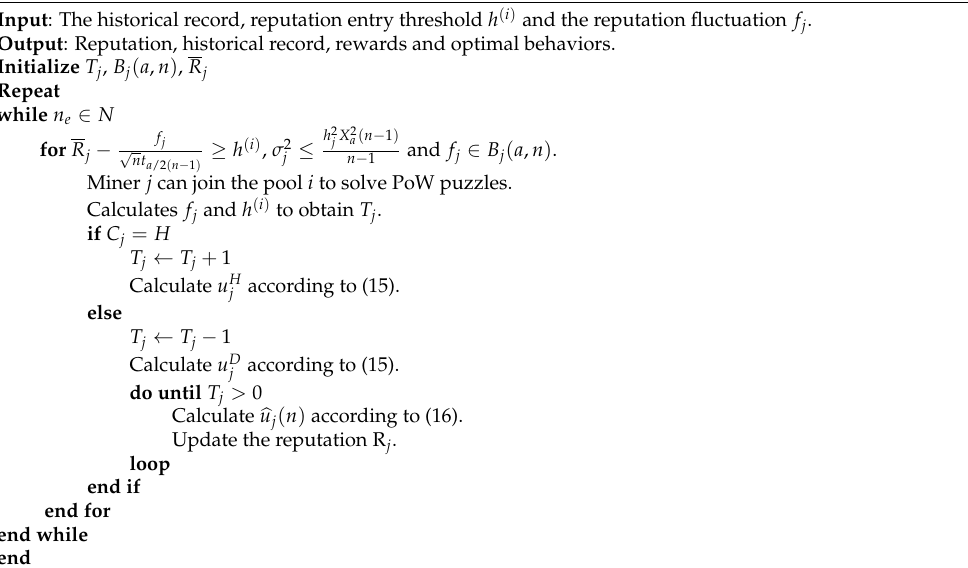
Figure 2. The logic flow diagram. Algorithm 1 Honesty behavior reputation update